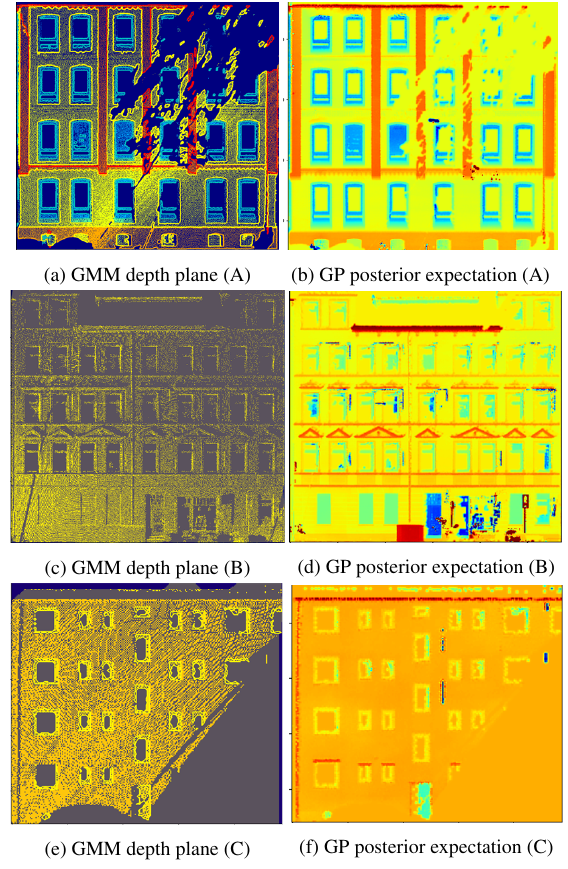
Figure 7. Examples of the modelled